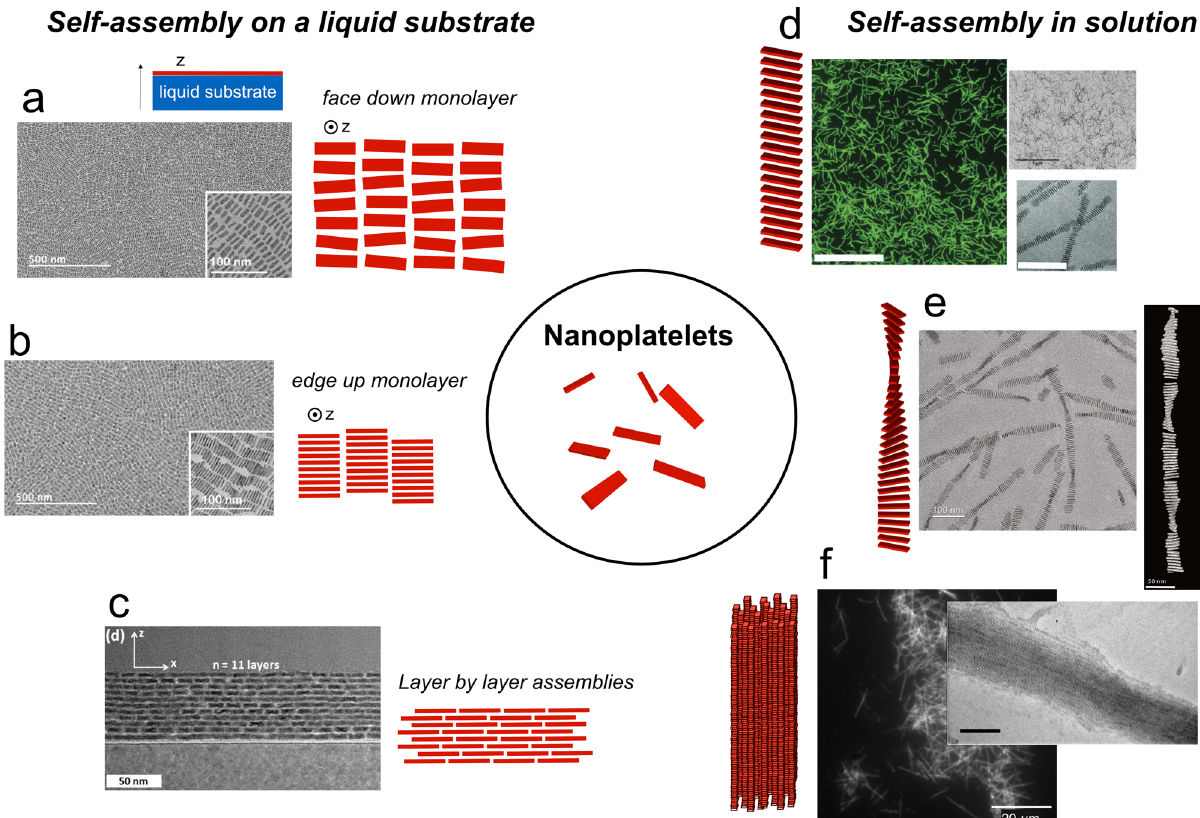
Fig. 3 Self-assembled structures of CdSe NPLs. Starting for colloidal NPLs (central scheme), self-assemblies can be performed on a liquid substrate,